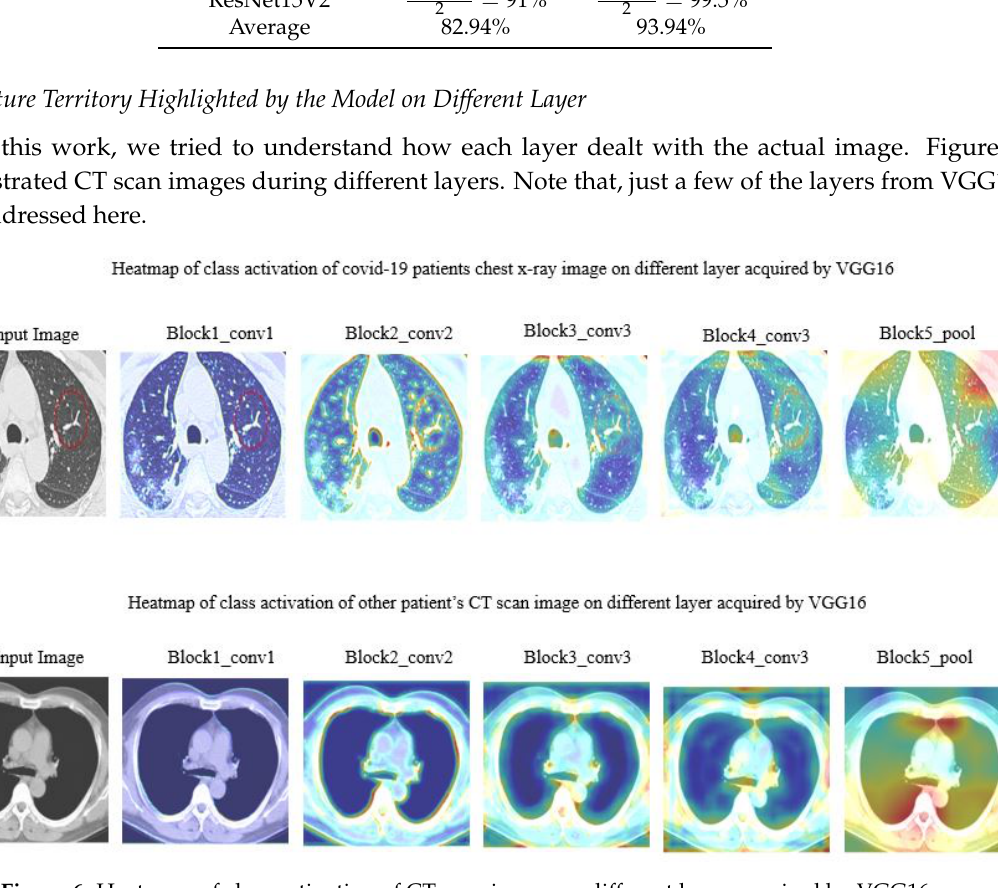
Figure 6. Heat map of class activation of CT scan image on different layer acquired by VGG16. Figure 7 manifested the different layer’s activity of model ResNet50 on chest X-ray images. The region spotted by model ResNet50 was highlighted with a